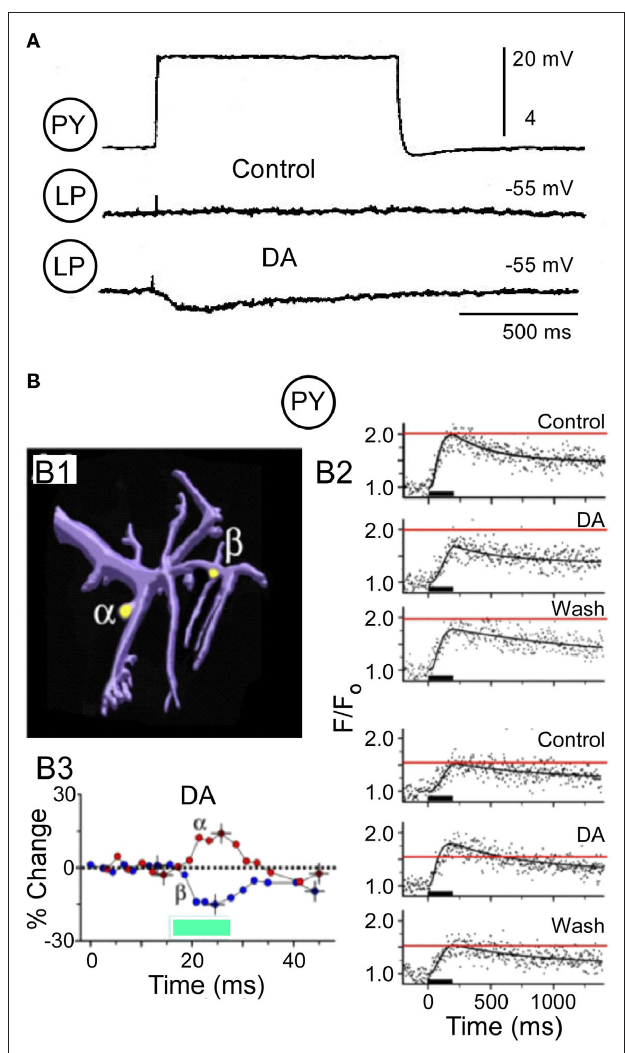
Figure 4 | Dopamine (DA, 10 − 4 M) modulates the PY → LP graded synapse. (A) Pre-synaptic PY depolarization (top) and LP responses under control conditions (middle) and during DA (bottom) (modified from Johnson et al., 1994). (B) DA evokes opposing changes in voltage-dependent Ca 2 + accumulation in two varicosities on a neurite from a PY neuron (modified from Kloppenburg et al., 2007). B1: Computer reconstruction of an imaged PY neurite, indicating the two varicosities analyzed for Ca 2 + entry in response to a 200-ms depolarizing voltage pulse. B2: Quantified changes in percent fluorescence extracted from the line scans at alpha and beta varicosities. Dopamine reduces voltage-activated Ca 2 + activation at site alpha and increases the Ca 2 + signal at site beta. B3: Time course of the DA-induced changes of the peak Ca 2 + accumulation at the two